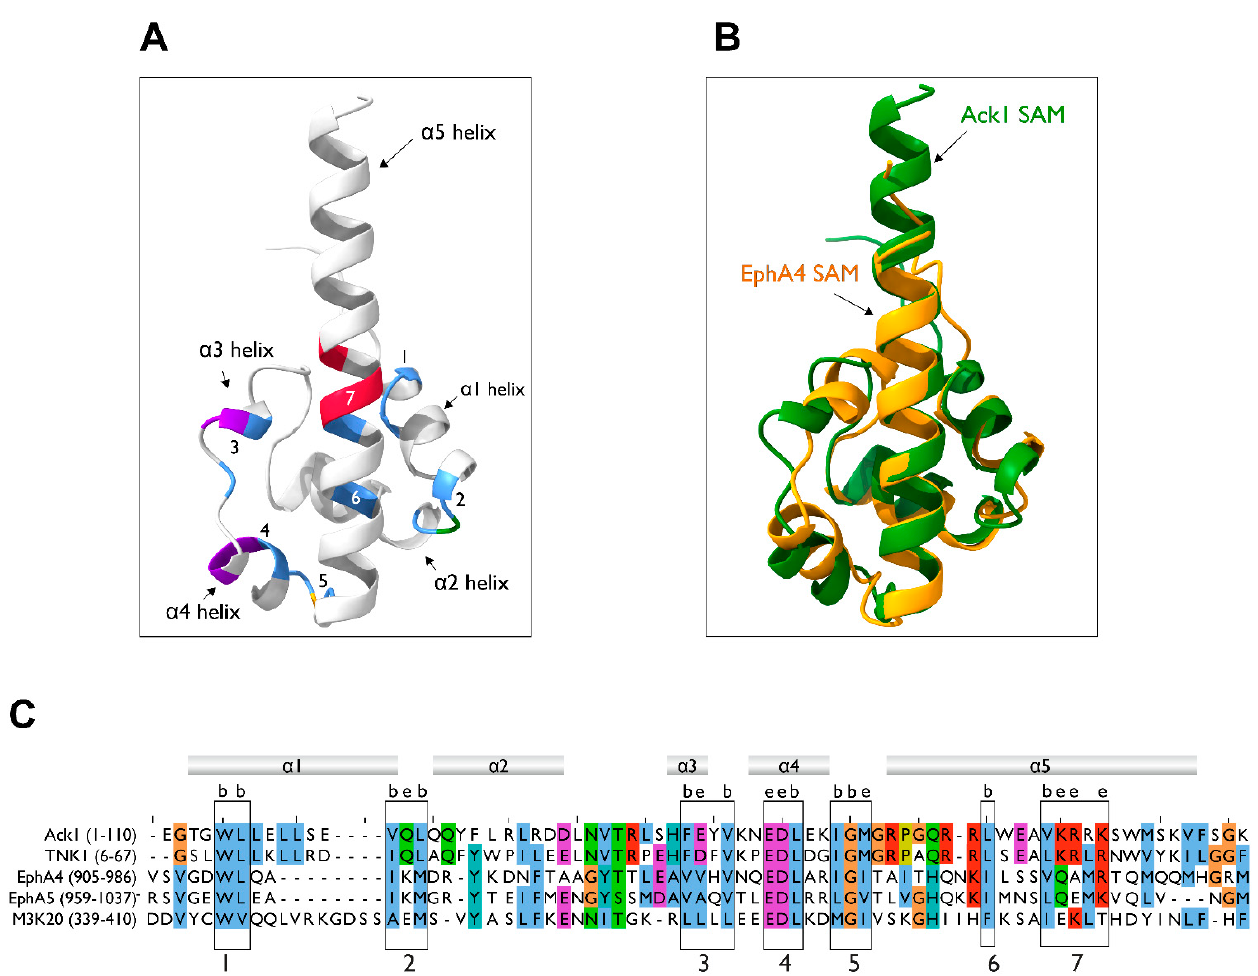
Figure 6. Homology modeling of the SAM domain. ( A ) AlphaFold model of the Ack1 SAM domain. The Ack1 SAM domain is predicted to adopt a typical SAM domain fold, with four short α helices, α 1- α 4, and a long C-terminal α -helix, α 5. Numbers denote the location of the boxes in panel ( C ). ( B ) Superimposition of the predicted Ack1 SAM domain and the EphA4 SAM domain (PDB: 1B0X). ( C ) Multiple sequence alignment of the SAM domains of human Ack1 and TNK1, EphA4, EphA5, and ZAK (M3K20) kinases. The numbers in parentheses denote the residues used as the inputs. Consensus sequences for SAM are highlighted in numbered boxes. The letters b and e denote the residues predicted to be buried or exposed,